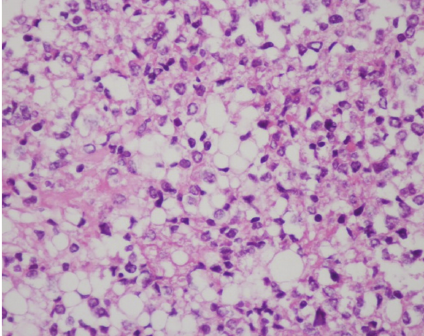
Figure 2: Histology results showing a typical field of liponeuro- cytoma; small round cells admixed with lipomatous cells. HES, original magnification ×